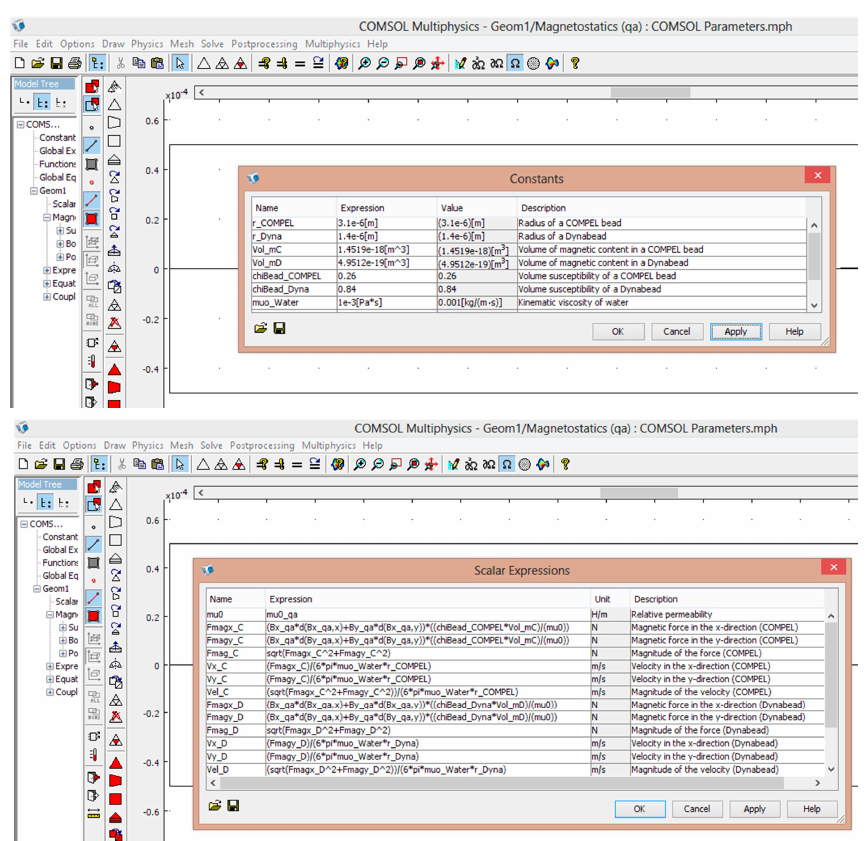
Figure A3. COMSOL constants and expressions for calculating magnetic force and velocity.